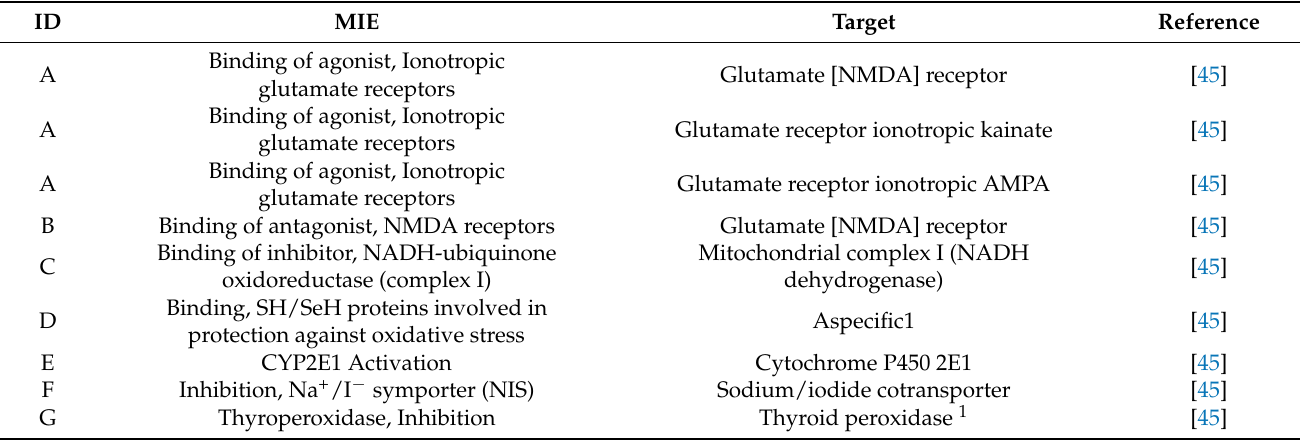
Table 3. Molecular Initiating Events associated with Developmental Neurotoxicity, adapted from Spînu et al. [45] and Li et al.